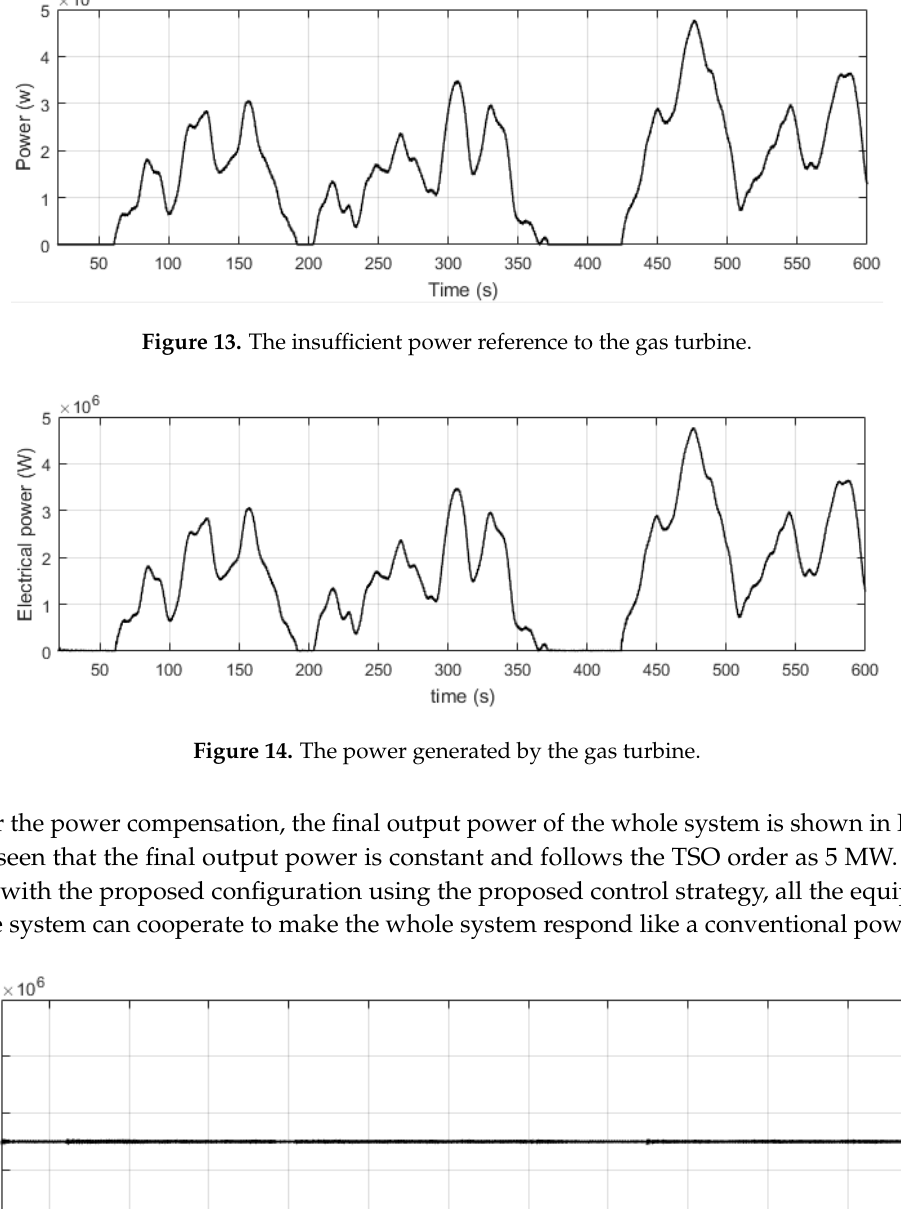
Figure 15. The final output power of the system .